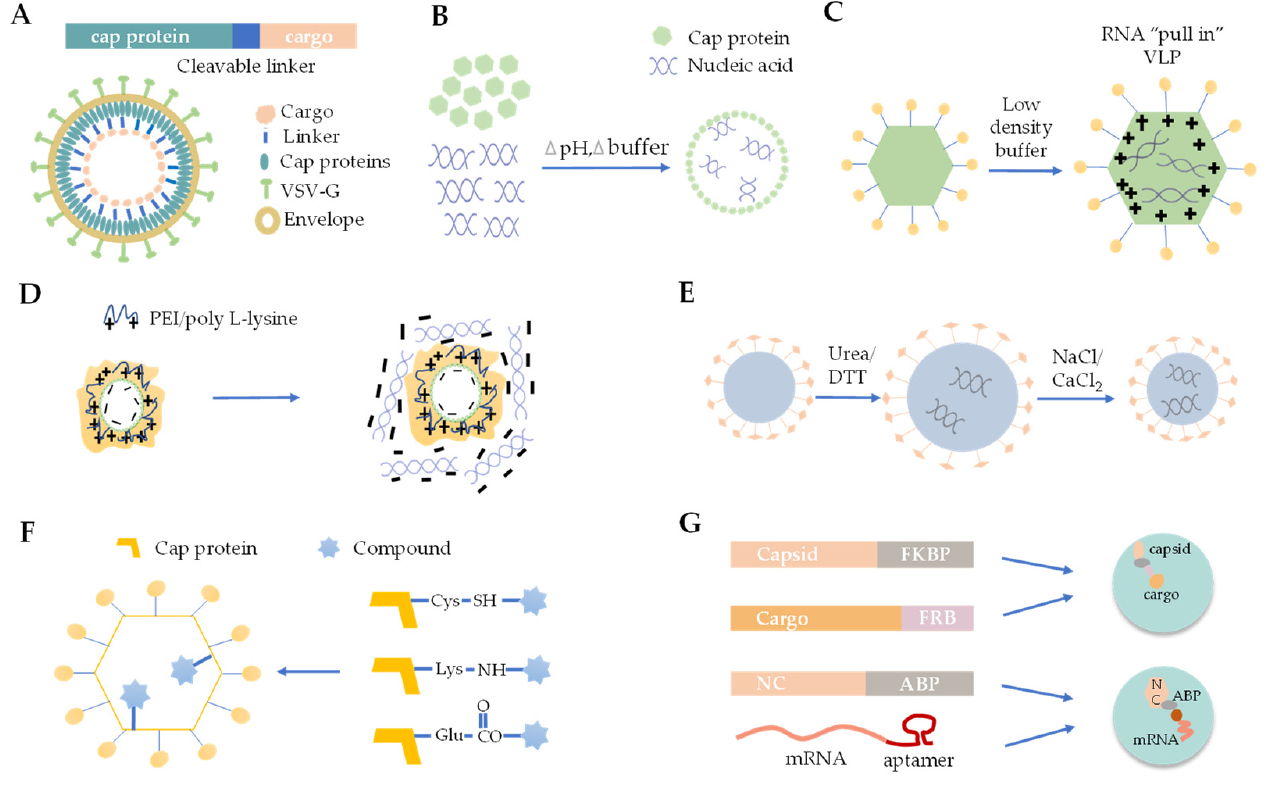
Figure 2. The strategies for cargos loading VLPs. ( A ) The strategy of foreign protein fusion. ( B ) De novo packaging of nucleic acids. ( C ) Osmotic shock. ( D ) Electrostatic adsorption. ( E ) Disassembly and reassembly. ( F ) Chemical linking. ( G ) Physical interaction between VLP and cargo.